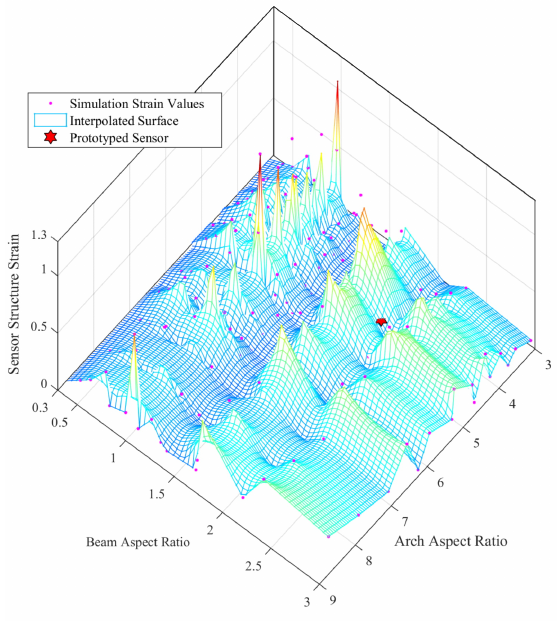
Figure 9. Sensor strain vs. structural design parameter study for the cylindrical arch